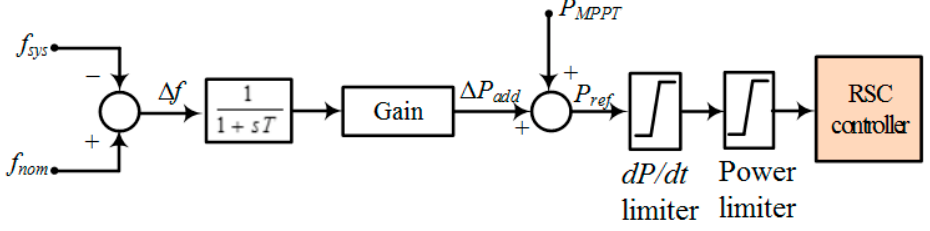
Figure 3. Diagram of the frequency control method.